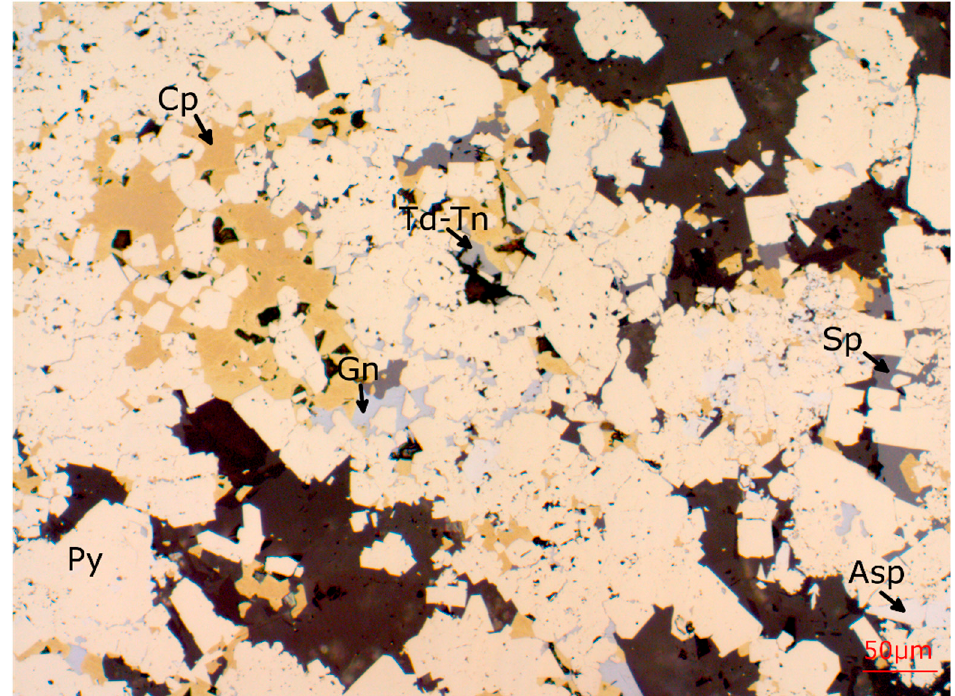
Figure 4. Reflected light photomicrograph showing the sulphide phases present in the L4-7-105.7 polished thin section. Ductile sulphides (Gn, Cp, Sp, Td-Tn) are concentrated in the interstices of coarser grained pyrite, whereas arsenopyrite is finely intergrown with the m.g. to c.g. porphyroblastic pyrite.